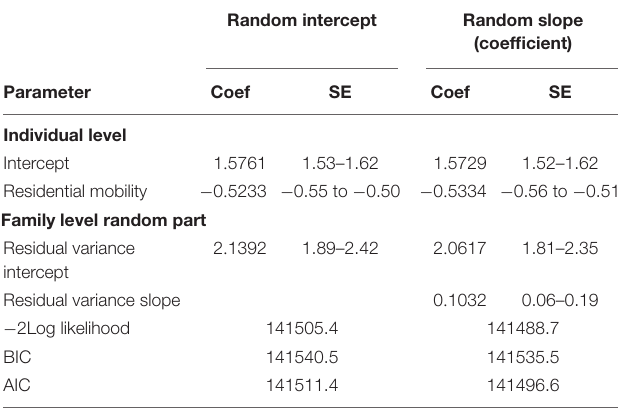
TABLE 3 | Parameter estimates and log-likelihood values for the random intercept and random slope logistic regression